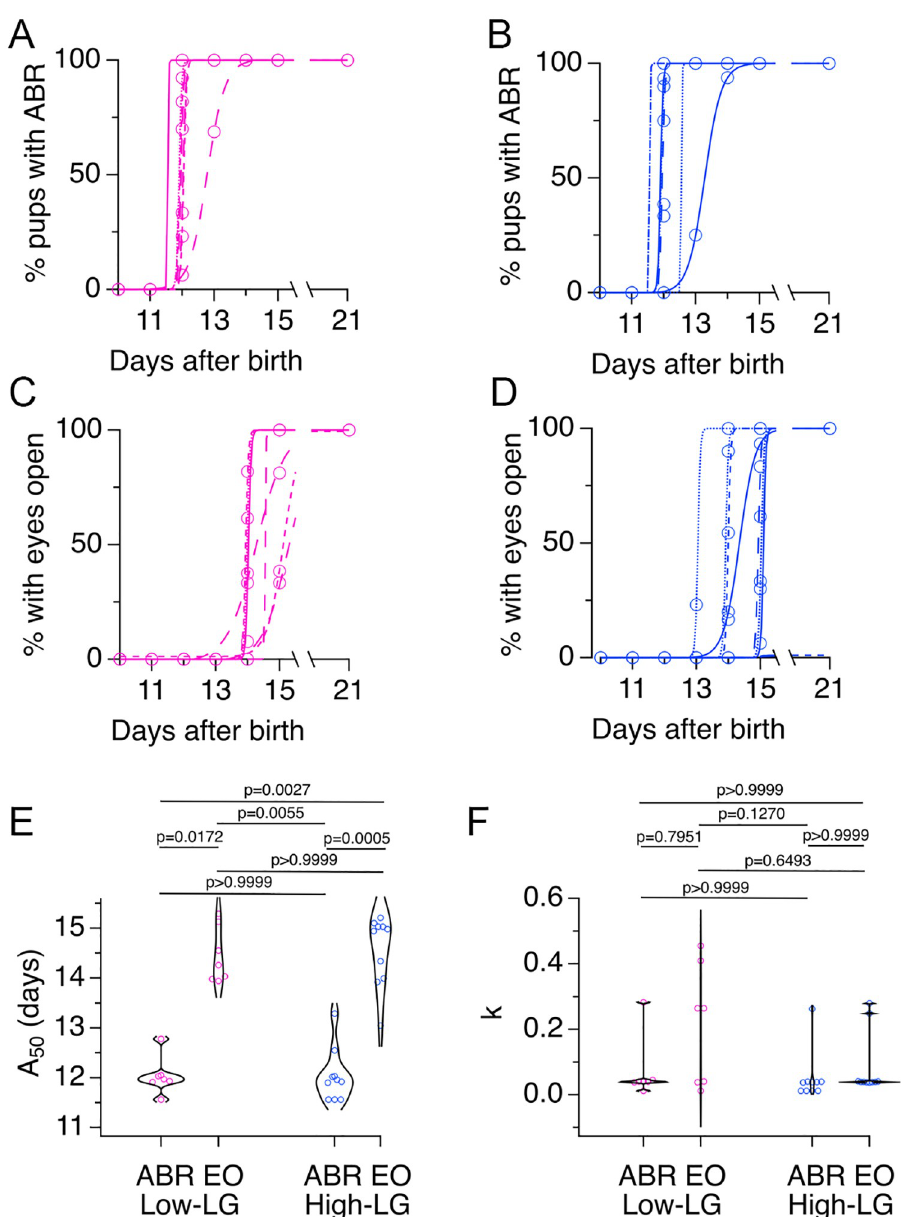
Fig 3. Timing of auditory brainstem response (ABR) onset and eye opening (EO) in the offspring of selected dams. A , Plots of percent pups with ABR wave 1 at different ages from seven low licking and grooming (low-LG) litters were fit to Eq 1. B , Plots of percent pups with ABR wave 1 at different ages from ten high licking and grooming (high-LG) litters were fit to Eq 1. C , Plots of percent pups with EO at different ages from seven low-LG litters were fit to Eq 1. D , Plots of percent pups with EO at different ages from ten high-LG litters were fit to Eq 1. E , Violin plots of A 50 values obtained from fits of Eq 1 to developmental data of percent pups with ABR or EO. F , Violin plots of rate coefficient k values obtained from fits of Eq 1 to developmental data of percent pups with ABR or EO. P values were obtained by the Kruskal-Wallis multiple comparisons test. Continuous, dotted, short-dash and long-dash lines in A-D represent fits to litter data from cohorts 1, 2, 3 and 4, respectively.